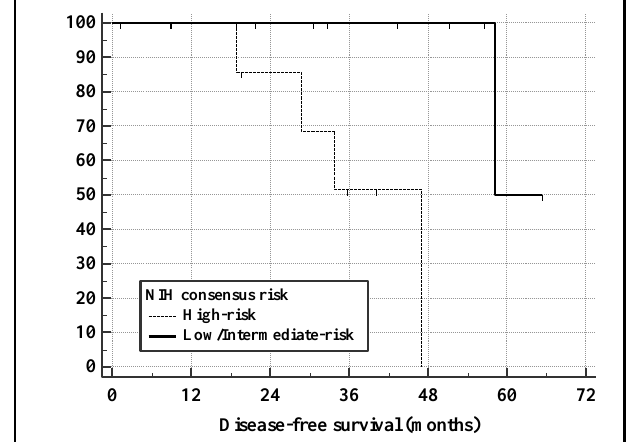
Figure 4: Kaplan-Meier disease-free survival curves according to the National Institute